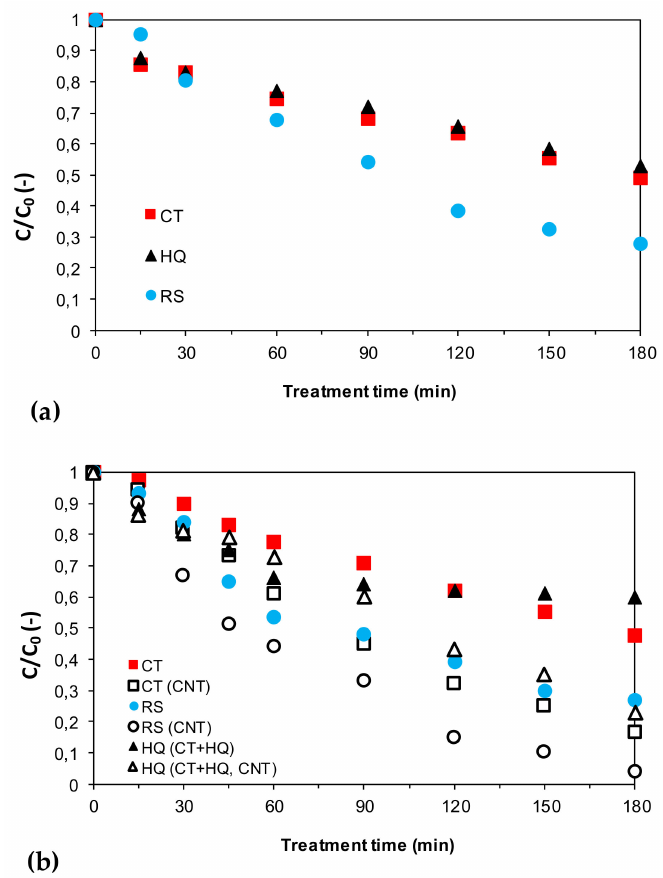
Figure 6. Normalized concentration profiles of dihydroxybenzenes during photocatalytic experiments in FPCR: ( a ) degradation of CT, HQ and RS in single pollutant model solutions using TiO 2 / CNT-GF; ( b ) degradation of CT (red and white squares) and RS (blue and white circles in CT + RS binary mixture using TiO 2 -GF and TiO 2 / CNT-GF, and degradation of HQ (triangles) in CT + HQ binary mixture using TiO 2 -GF and TiO 2 / CNT-GF at given experimental